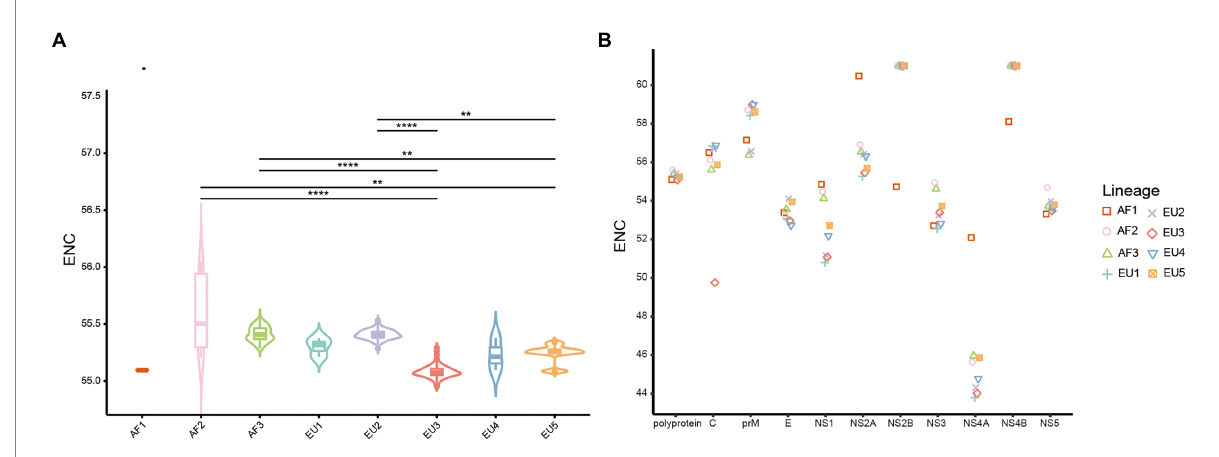
FIGURE 2 The effective number of codons (ENC) values distribution. (A) The violin plots with inner boxplots showed the ENC values of polyproteins of USUV in different lineages. Horizontal lines of inner boxplots represent median values, with whiskers extending to the farthest data point within a maximum of 1.5 × interquartile range. Benjamini-Hochberg (BH)-corrected Dunn’s test was performed to infer the significance between lineages. All differences with p < 0.05 are indicated. ** p < 0.01; *** p < 0.001; *** p < 0.0001. (B) The scatter plot shows the mean ENC values of individual coding sequences of USUV, considering the lineage classification of strains. The lineages are indicated by distinct scatter shapes and